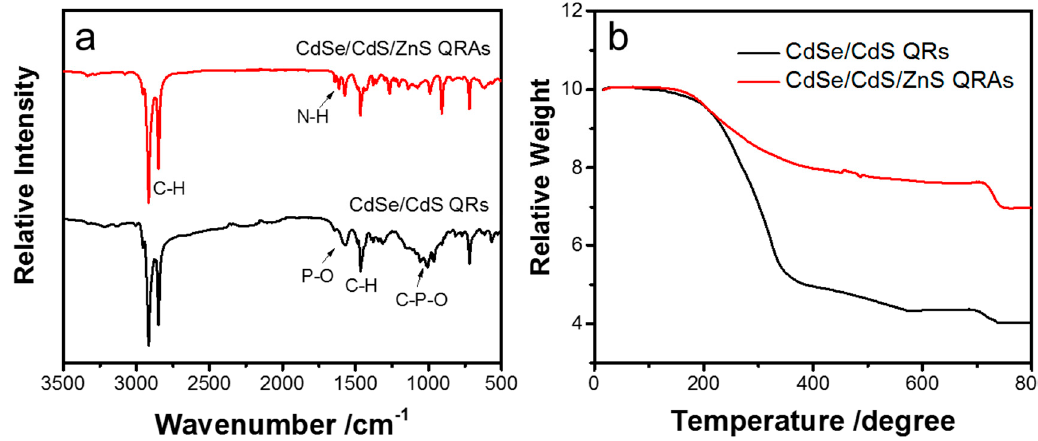
Figure 6. ( a ) FTIR spectra and ( b ) TG results of the CdSe/CdS QRs and CdSe/CdS/ZnS QRAs.